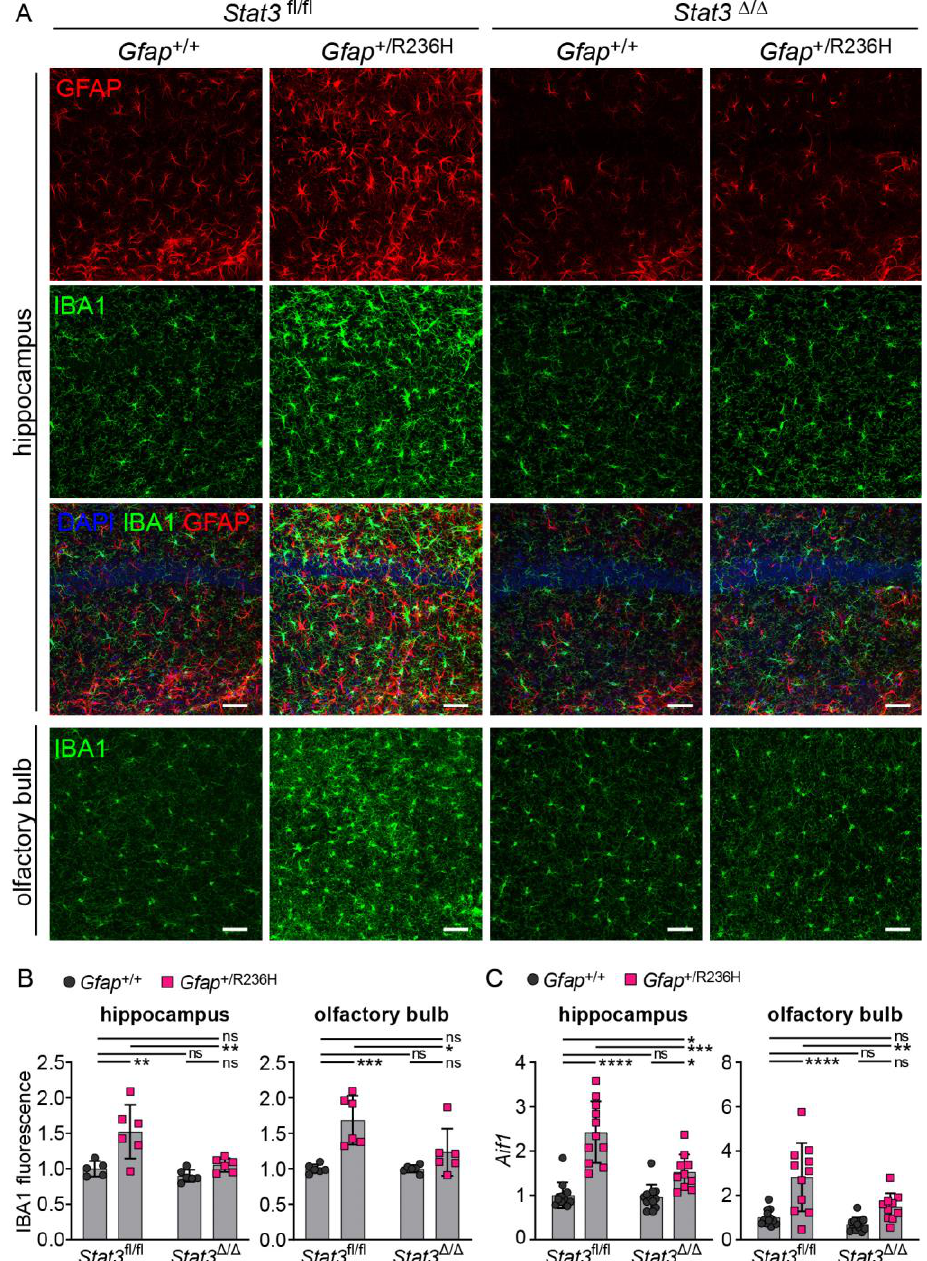
Figure 9. Microglial Iba1 expression in AxD model mice after inducible knockout of Stat3 in astrocytes. ( A , B ) Immunofluorescence labeling ( A ) and quantification ( B ) of Iba1 in hippocampus and olfactory bulb from Gfap +/R236H mice and Gfap +/+ littermate controls (3 months of age) derived from the same Stat3 fl/fl , CreER T2 genetic cross and tamoxifen treatment schedule as shown in Figure 7A. Stat3 alleles in animals expressing the Aldh1l1 -CreER T2 transgene are indicated as Δ (Stat3 Δ/Δ ). GFAP is also shown in hippocampus for comparison. ( C ) Quantification of Aif1 transcript (Iba1 gene, normalized to Rn18s ) in olfactory bulb and hippocampus by qPCR. Values represent fold change relative to the average for Gfap +/+ ; Stat3 fl/fl ; Cre (-) mice. C57BL/6J males and females, two-way ANOVA with Sidak’s post -tests, * p < 0.05, ** p < 0.01, *** p < 0.001, **** p < 0.0001, ns = not significant. Scale bars = 50 µm.